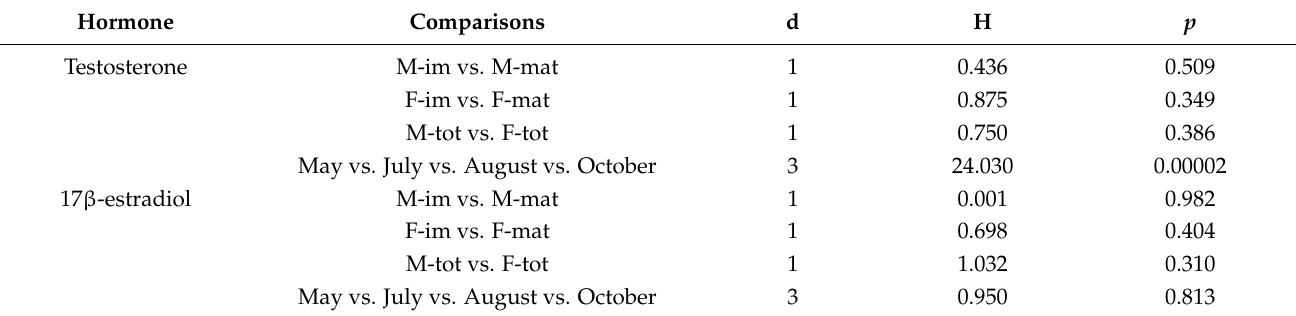
Table 1. Results of Kruskal–Wallis tests comparing the differences in sex hormone levels of red king crabs. Hormone Comparisons d H Testosterone M-im vs.